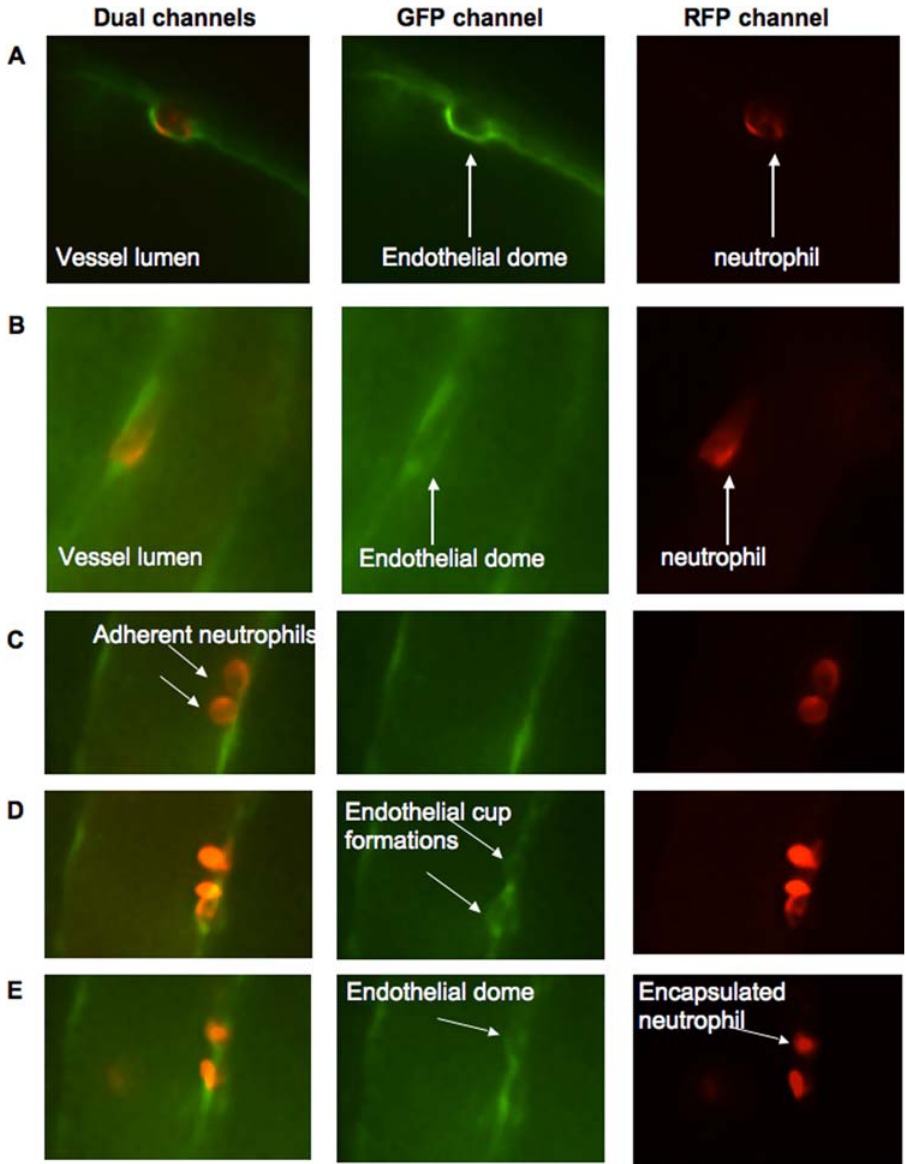
Figure 4. Endothelial dome formation using spinning disk confocal microscopy. Spinning disk confocal images of MIP-2 superfused cremaster muscle of mice with GFP positive endothelium (green) and GR-1 Alexa Fluor 555 stained neutrophils (red). Panels A and B show adherent neutrophils that have been covered by endothelium. By following the same vessel with two adherent neutrophils over time, dynamic formation of endothelial domes was